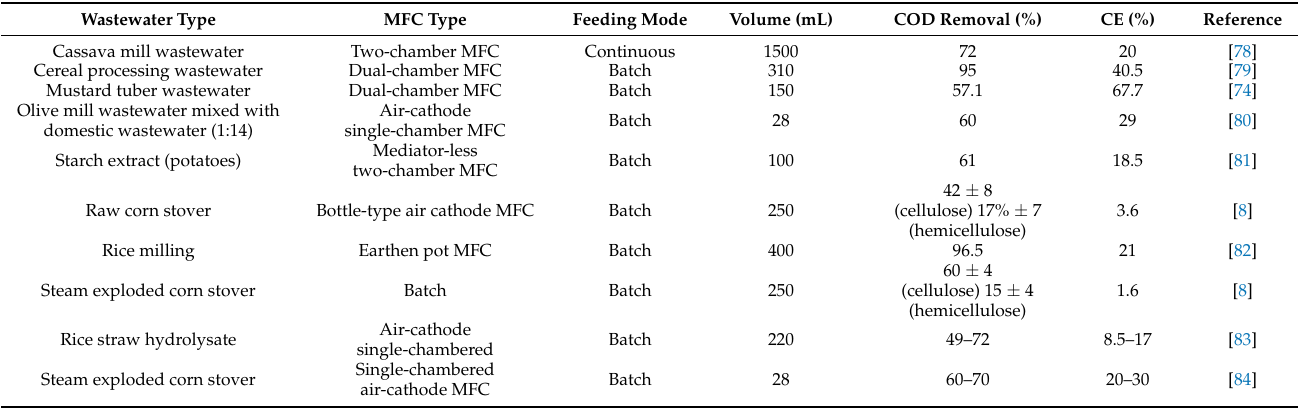
Table 2. MFC types and performance using different agricultural product processing